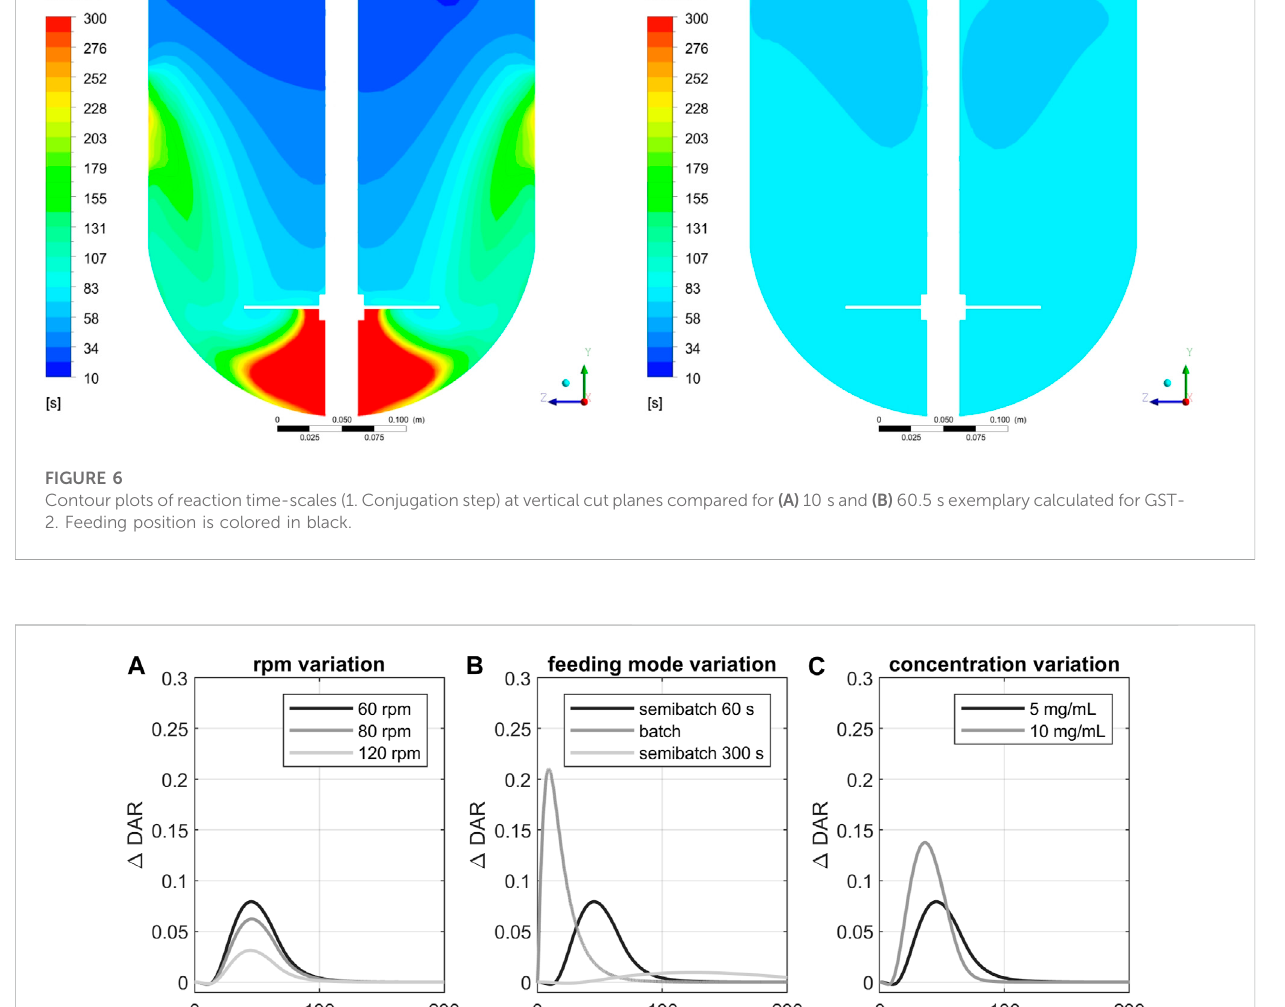
Frontiers in Bioengineering and